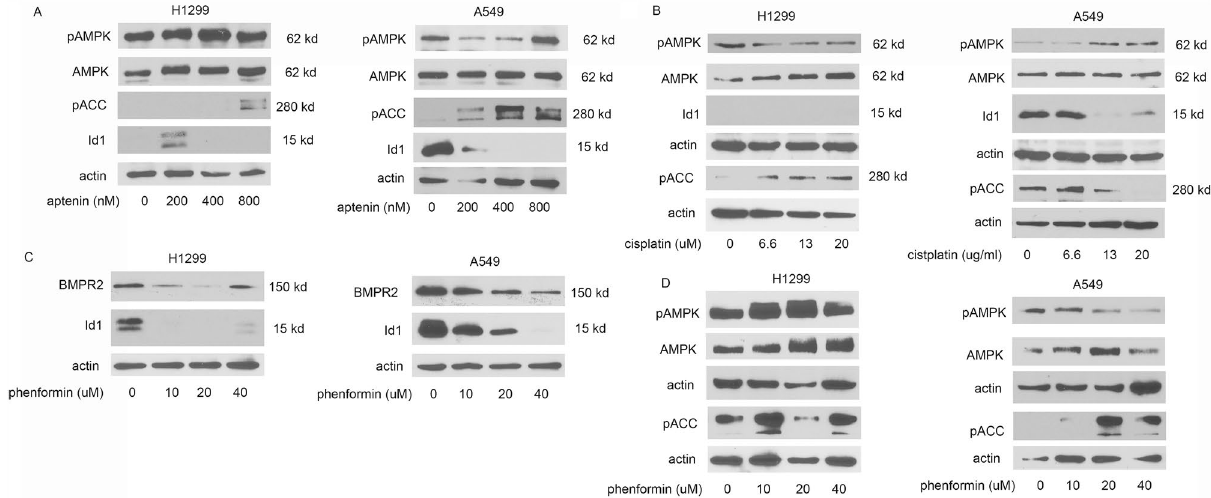
Figure 7. Mitochondrial inhibitors activate AMPK and downregulate BMP signaling. H1299 and A549 cells were treated with inhibitors for 24 h. ( A ) Immunoblots for cells treated with atpenin, ( B ) cisplatin, or ( C – D )